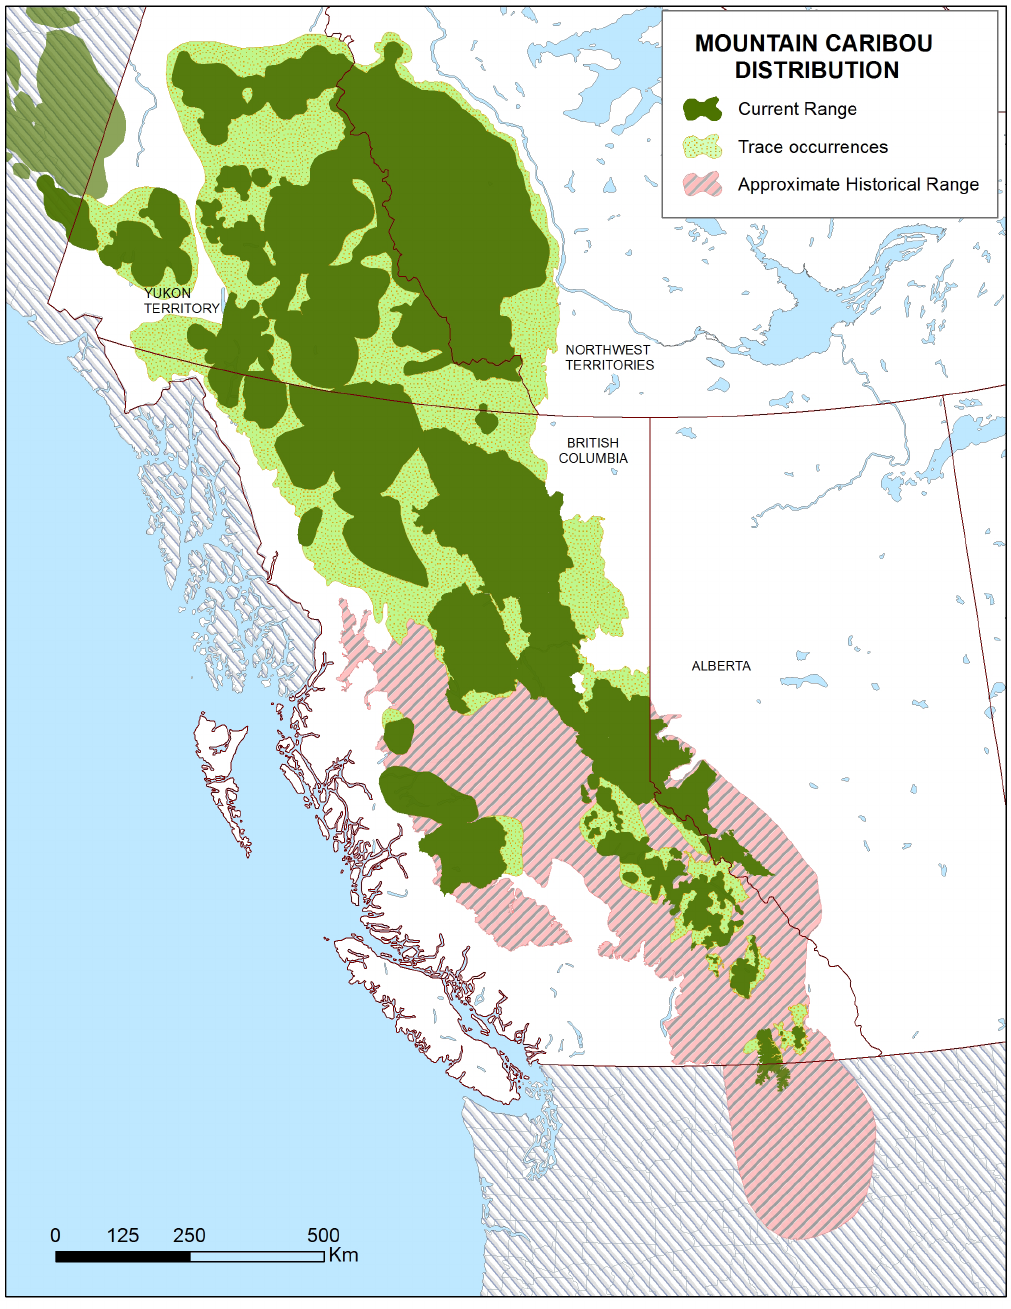
1. Approximate historic and current ranges of caribou in the mountain DUs of western Canada (from COSE- WIC 2014a). Map created by Bonnie Fournier (Environment and Natural Resources, Government of the Northwest Territories,